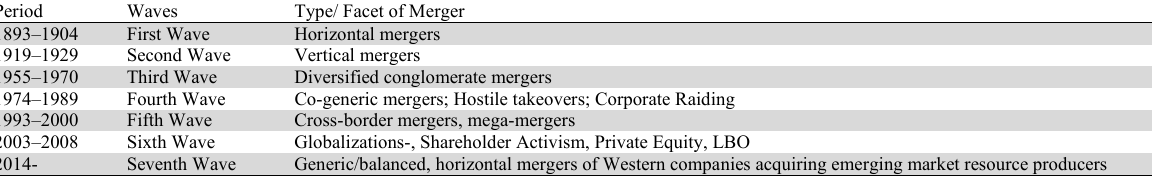
Exhibit the History of Merger Waves and Facet during Period Period